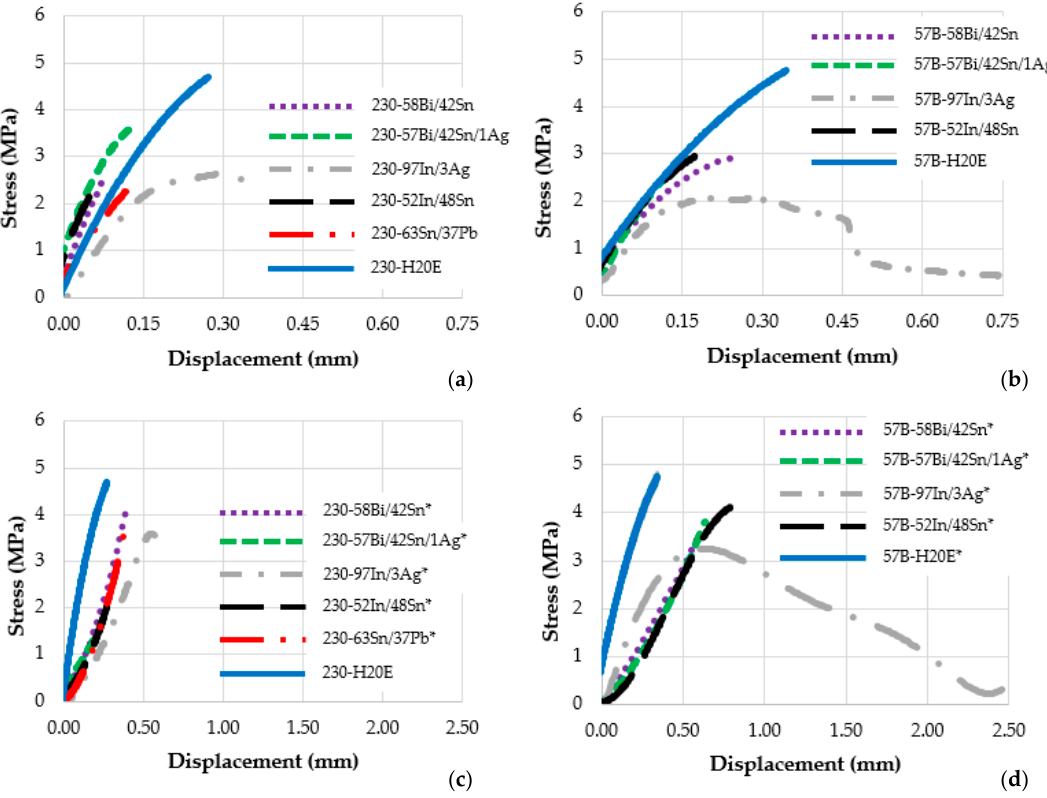
Figure 3. Representation of wire bond pull testing stress vs. displacement curves. ( a ) CB230 copper conductive ink with solvent flux remover, ( b ) HPS-FG57B silver conductive ink with solvent flux